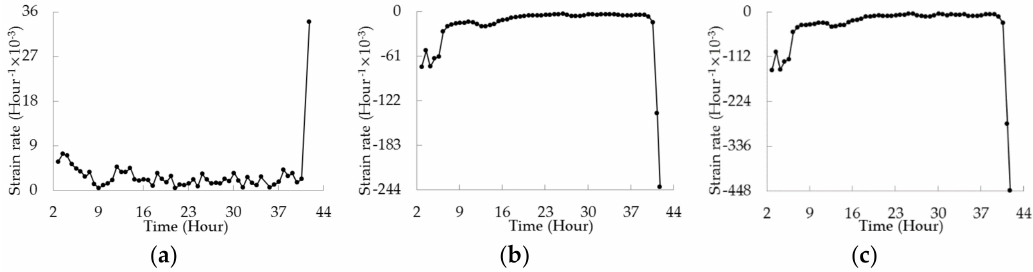
Figure 8. Strain rates versus time graphs for the coal sample compressed at 11.02 MPa: ( a ) axial strain rate (r a ); ( b ) radial strain rate (r r ); ( c ) volumetric strain rate (r v